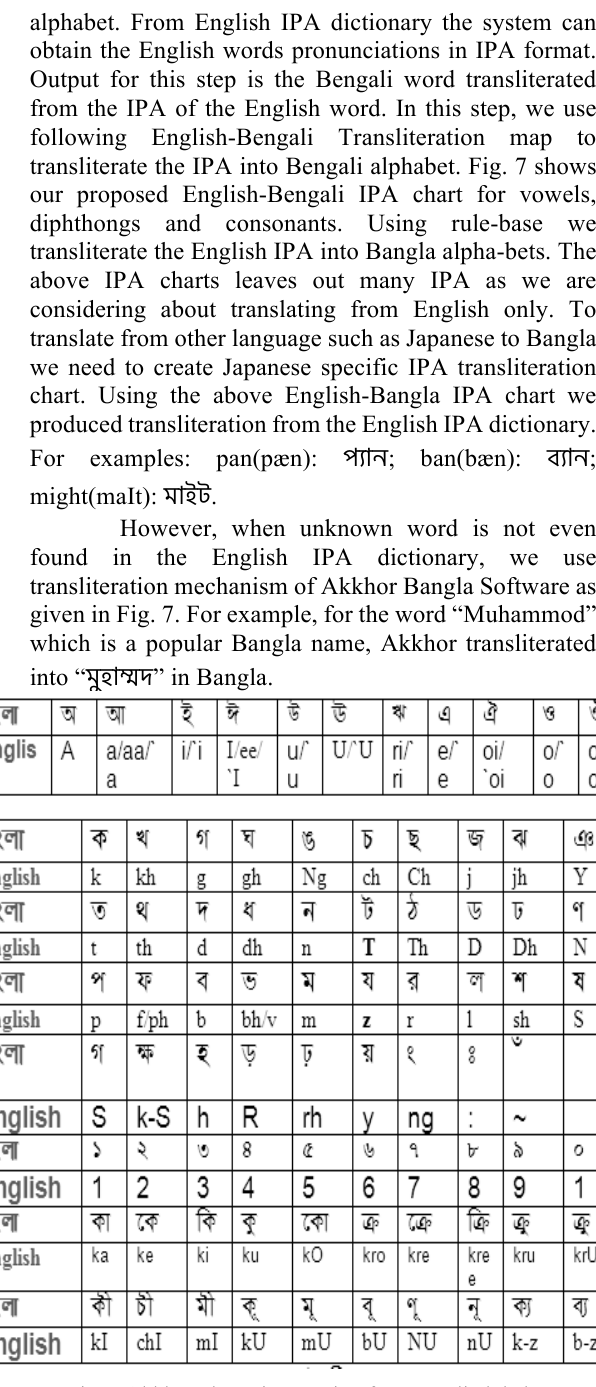
Fig. 7 Akkhor phonetic mapping for Bengali